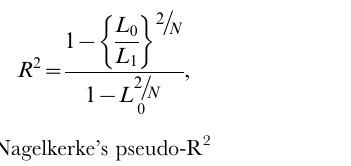
Figure S2 Regional associational plots for the non-classical HLA region spanning MICB-LST1. The figure displays the minus logarithmic p-values ( 2 log 10 P) for the SNPs in the MHC region that includes class I and class III non-classical MHC genes. Panel A has the 2 log 10 P for the univariate analysis, and panel B the 2 log 10 P adjusting for DRB1*15:01 in the model. Shades of red represent the r2 between the SNPs and the best marker, i.e.